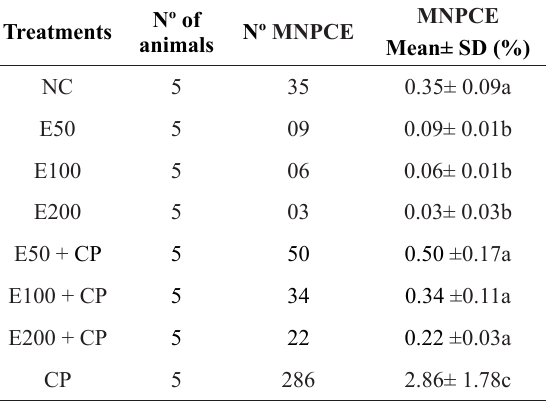
Frequency of erythrocytes polychromatics micronucleuds (MNPCEs) of bone marrow cells of Swiss mice in experimental groups treated with hidroethanolic extract of H. courbaril